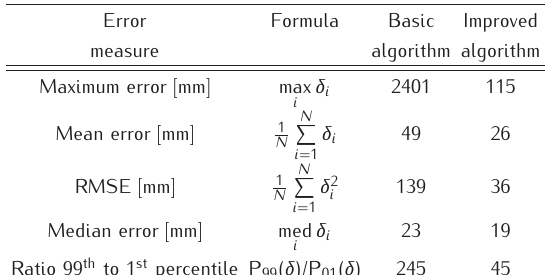
Figure 10. Histograms of errors of the basic and improved algorithm for all test series.